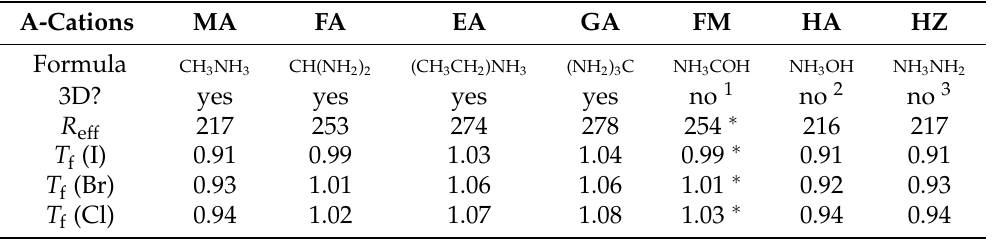
Table 1. A-site cations considered here used to form 3D mixed-halide perovskites. The Goldschmidt tolerance factor is calculated for each halogen type. The listed cation effective radii (except FM) were adopted from Kieslich et al. [34]. The ionic radii of the constituent elements are R Pb = 196, R Cl = 188, R N = 146, R O = 135, adopted from Shannon [35]. All ionic radii are given in R Br eff eff eff eff [pm]